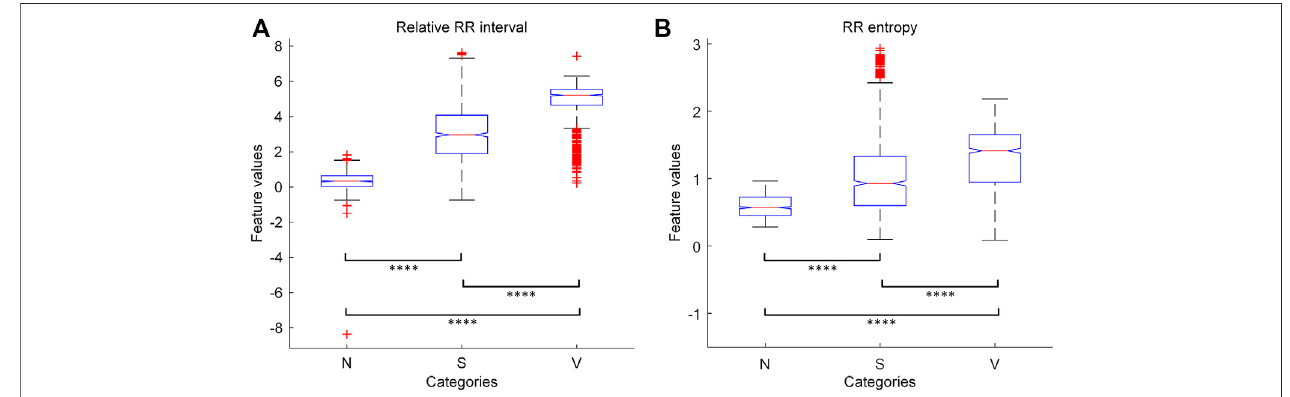
FIGURE 3 | The results of one-way ANOVA with multiple pairwise comparison for the knowledge-based features. (A) The results for relative RR interval. (B) The resultsforRRentropy.Thesymbol “ **** ” indicatesthatthecorrespondingtwogroupsaresigni fi cantly( p < 0.0001)differentfromeachotherinfeaturesvalues.N=normal or bundle branch block beat. S = supraventricular ectopic beat. V = ventricular ectopic beat.